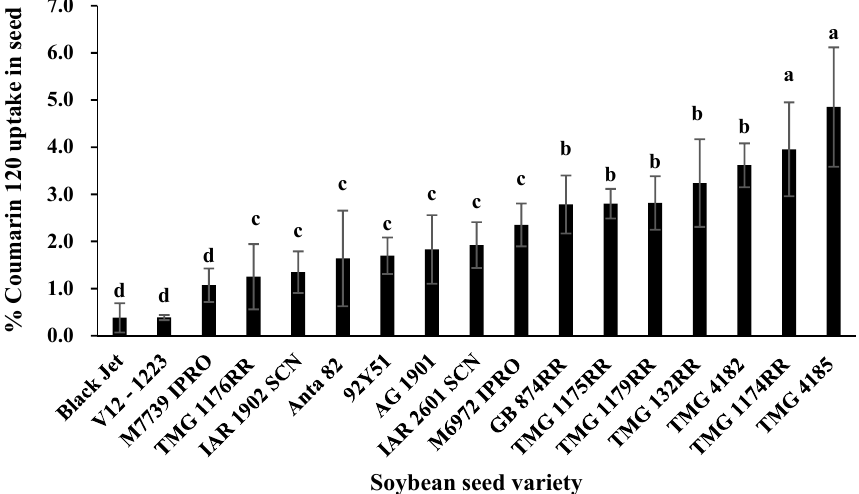
Figure 2. Seed uptake efficiency (percent uptake based on the total amount of coumarin 120 (C120) applied as a seed treatment) in 17 soybean varieties. Means for soybean seed varieties with the same letter are not significantly different from each other (Tukey HSD test, P < 0.05). Bars represent standard error of the mean.